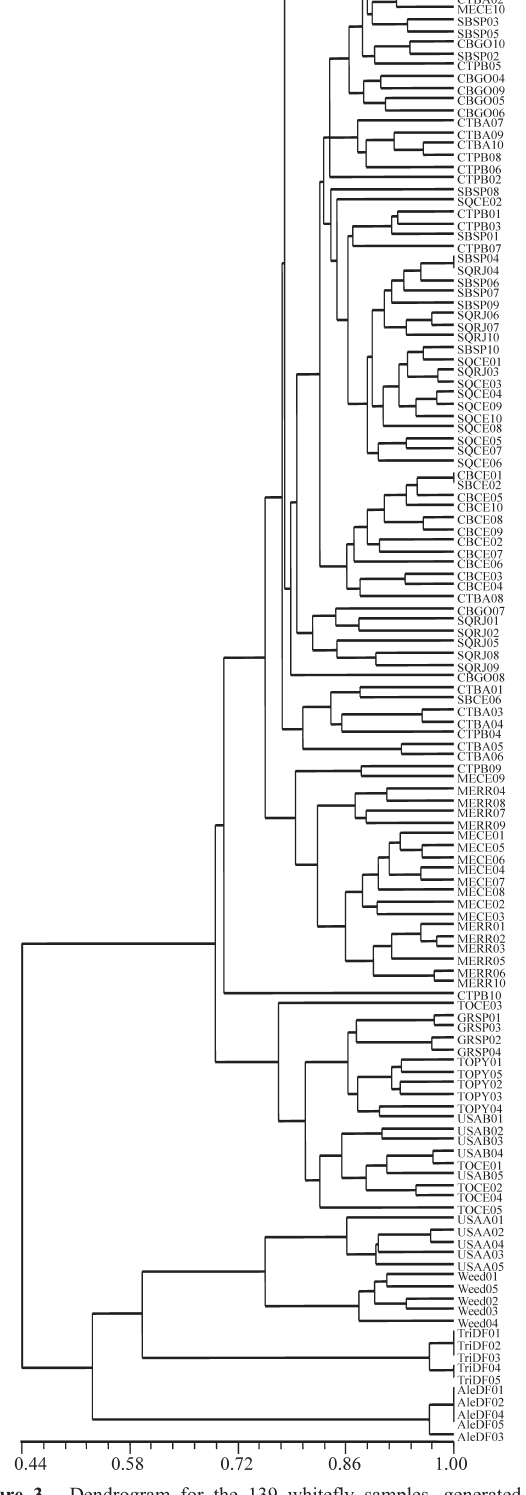
Figure 3 - Dendrogram for the 139 whitefly samples, generated by UPGMA. Population codes are listed in Table